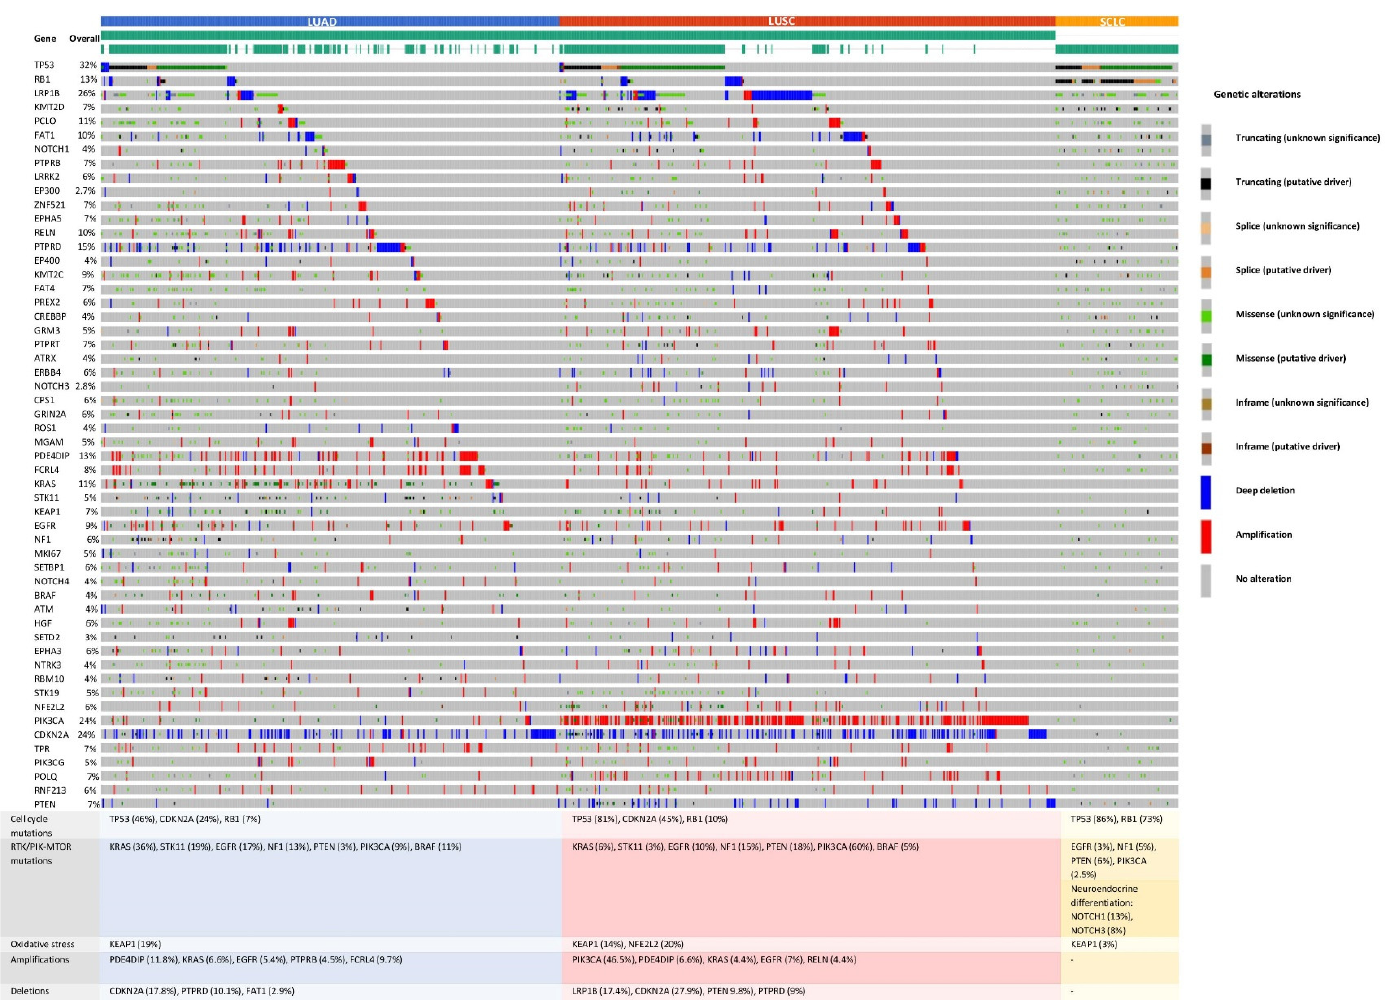
Figure 2. Genetic alterations identified in the TCGA lung cancer datasets. (top) Lung adenocarcinoma (LUAD) (blue), lung squamous cell carcinoma (LUSC) (red), and small-cell carcinoma (SCLC) (orange). Overall genetic alterations in each of the three main histotypes of lung cancer in the top 54 most common genes that harbor gene alterations (left). Review of the prevalence of different genetic alterations in key molecular pathways separated based on the histological type (bottom).